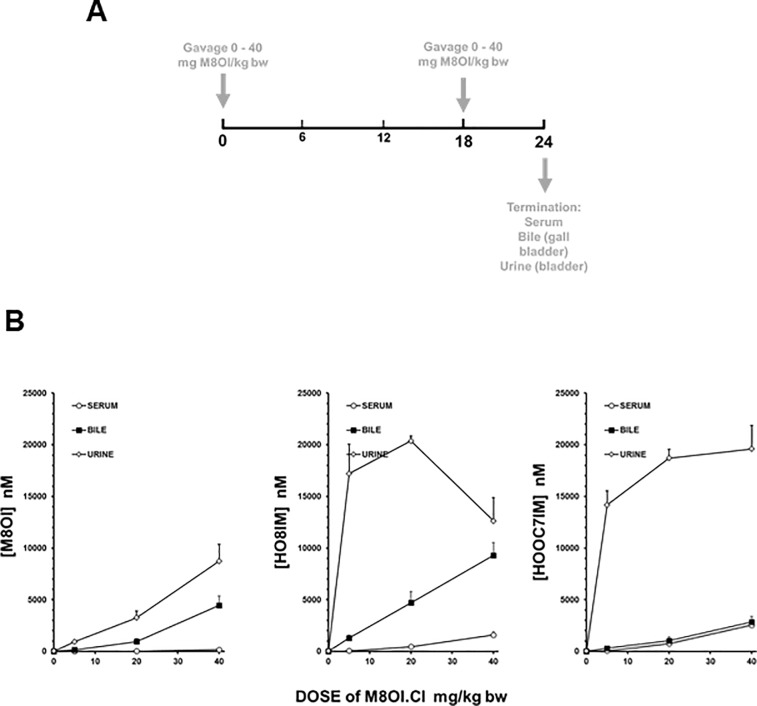
The disposition of M8OI in the mouse after oral gavage.A, schematic diagram of dosing regimen used. B, serum, bile and urine concentrations of M8OI or the hydroxylated (HO8IM) and carboxylated (HOOC7IM) metabolites at termination. Data are the mean and SD of 5 individual animal serum samples at any one timepoint. Bile and urines data are the mean and SD of between 3 and 5 individual animal samples. Note, in some cases, sufficient urine or bile was not obtained from an animal.